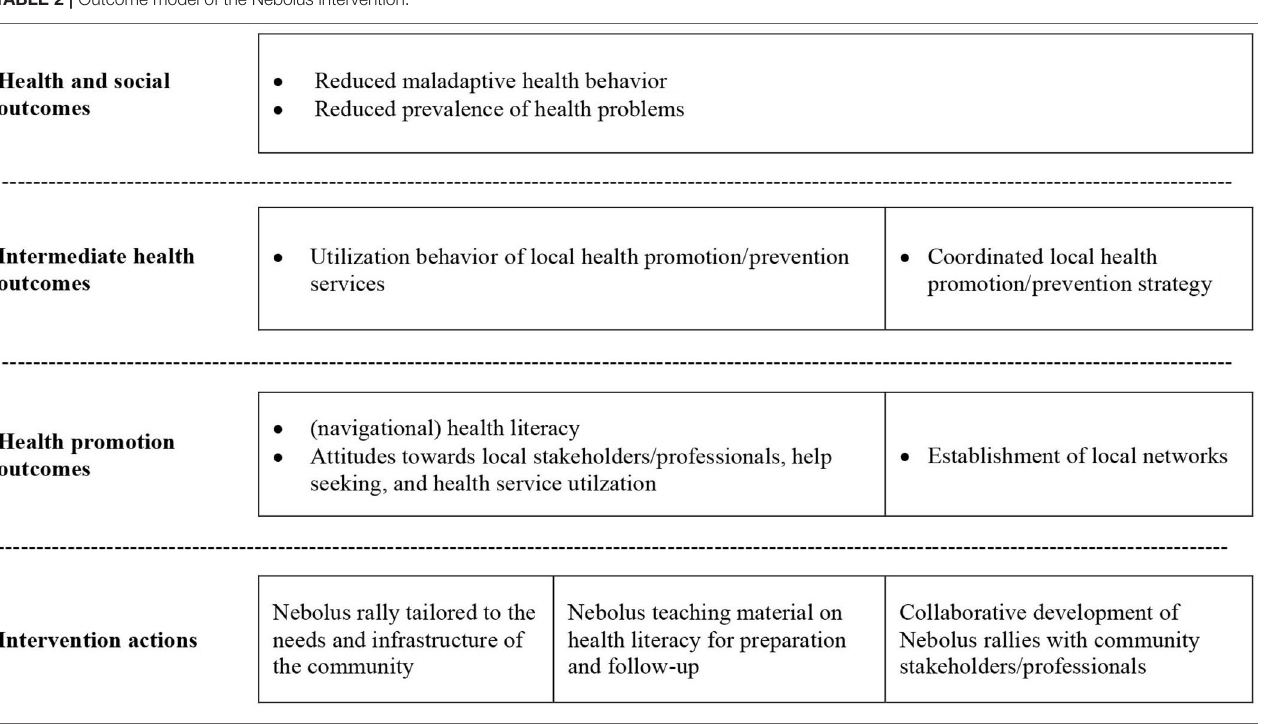
TABLE 2 | Outcome model of the Nebolus intervention.